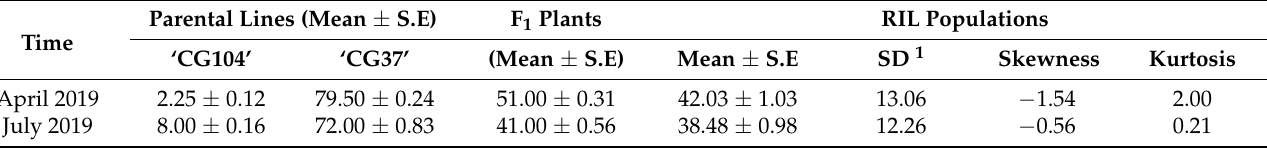
Table 1. The salt injury indexes of the parental lines, F 1 plants, and recombinant inbred line (RIL) populations. Parental Lines (Mean ± S.E) F 1 Plants Time